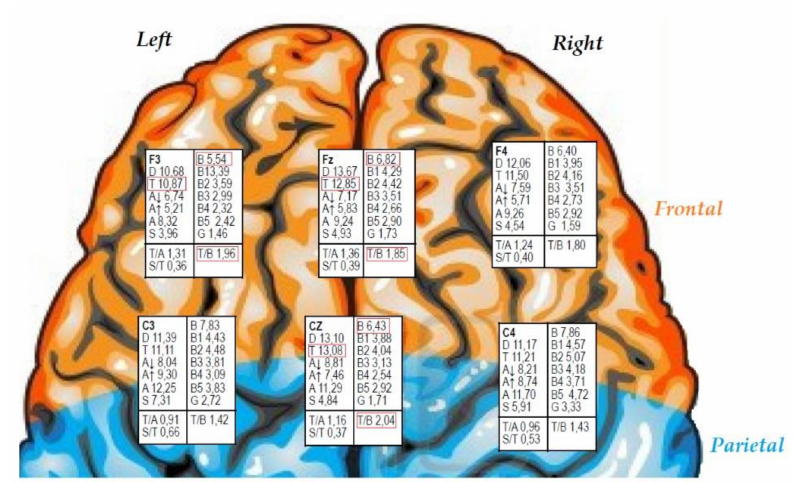
Figure 1. Pre-treatment results from the MiniQ instrument. Note . T = theta; B = beta; T/B = theta/beta ratio. In subjects aged between 7 and 11 years old, values over 2.8 for the theta/beta ratio are compatible with a profile of